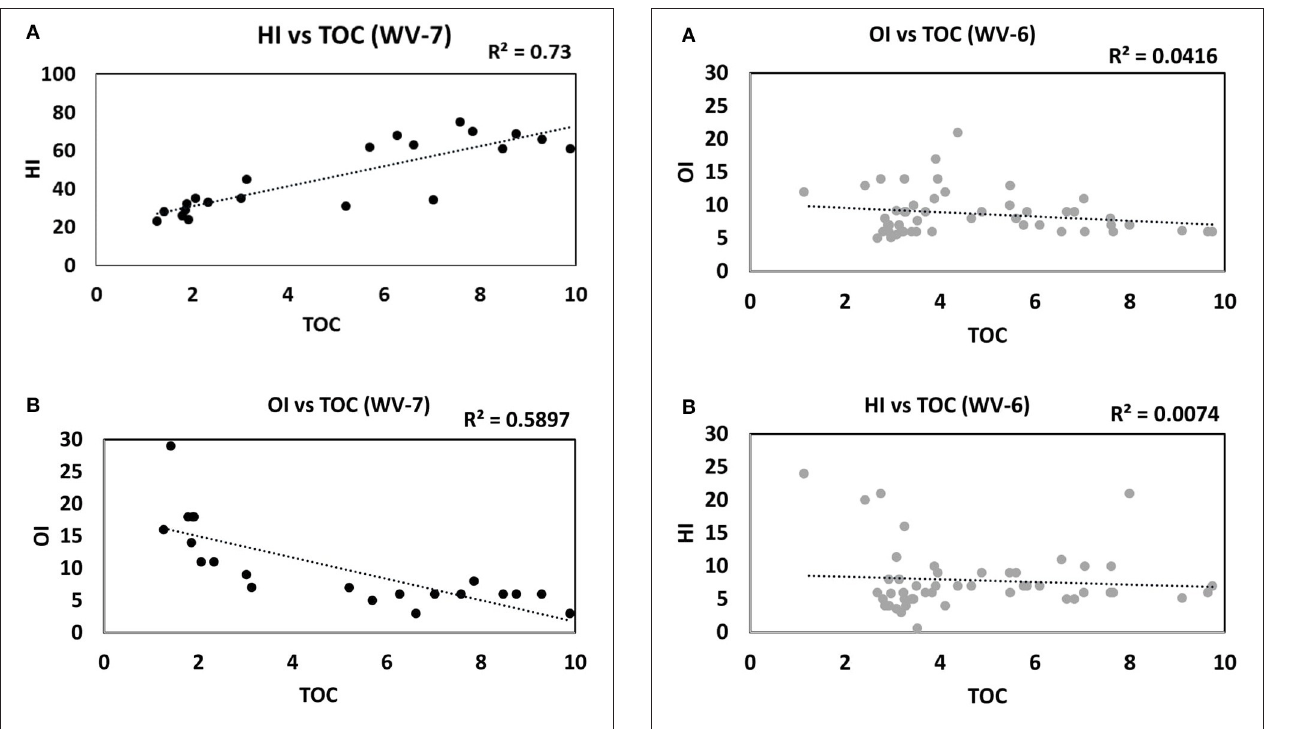
predominately oxidizing conditions, and the values between 1.0